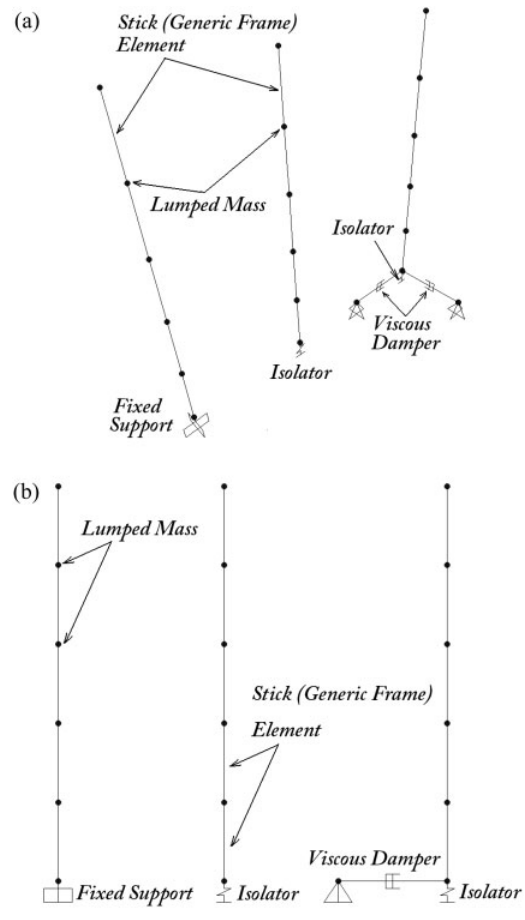
Fig. 1. SAP2000 MDOF